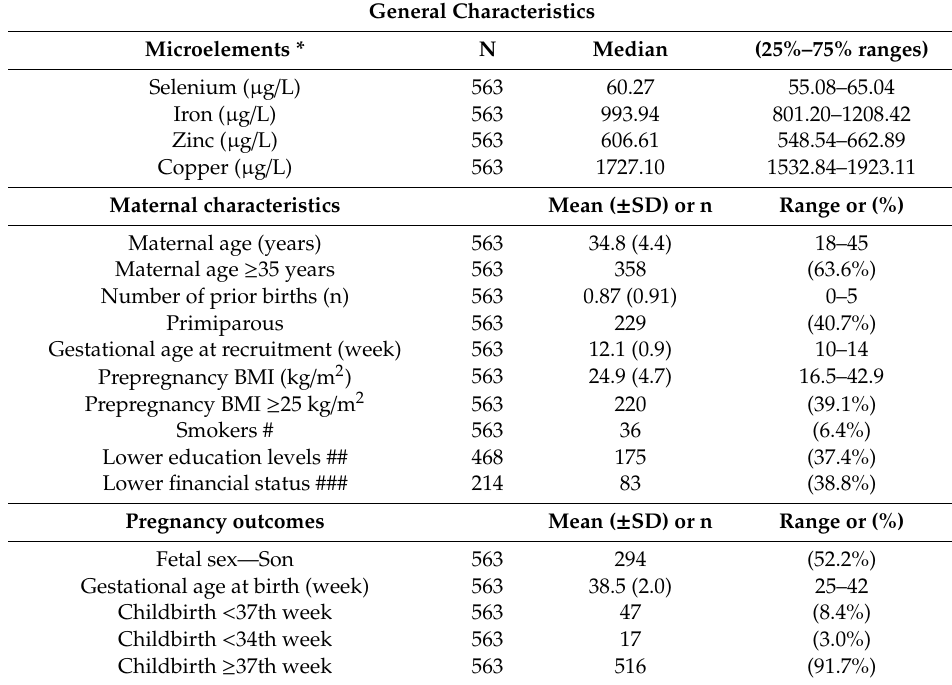
Table 1. General characteristics of the whole